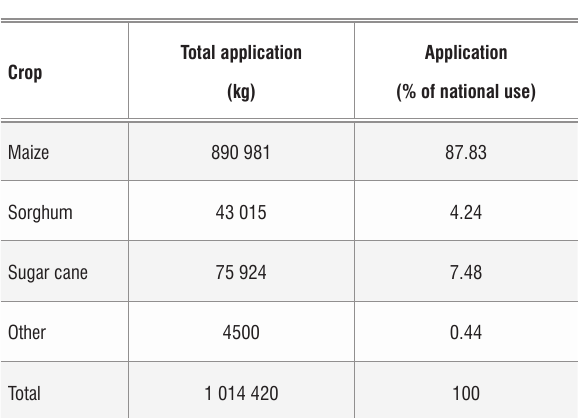
Example of a summary of the application of atrazine to crops produced in South Africa for the year 2009